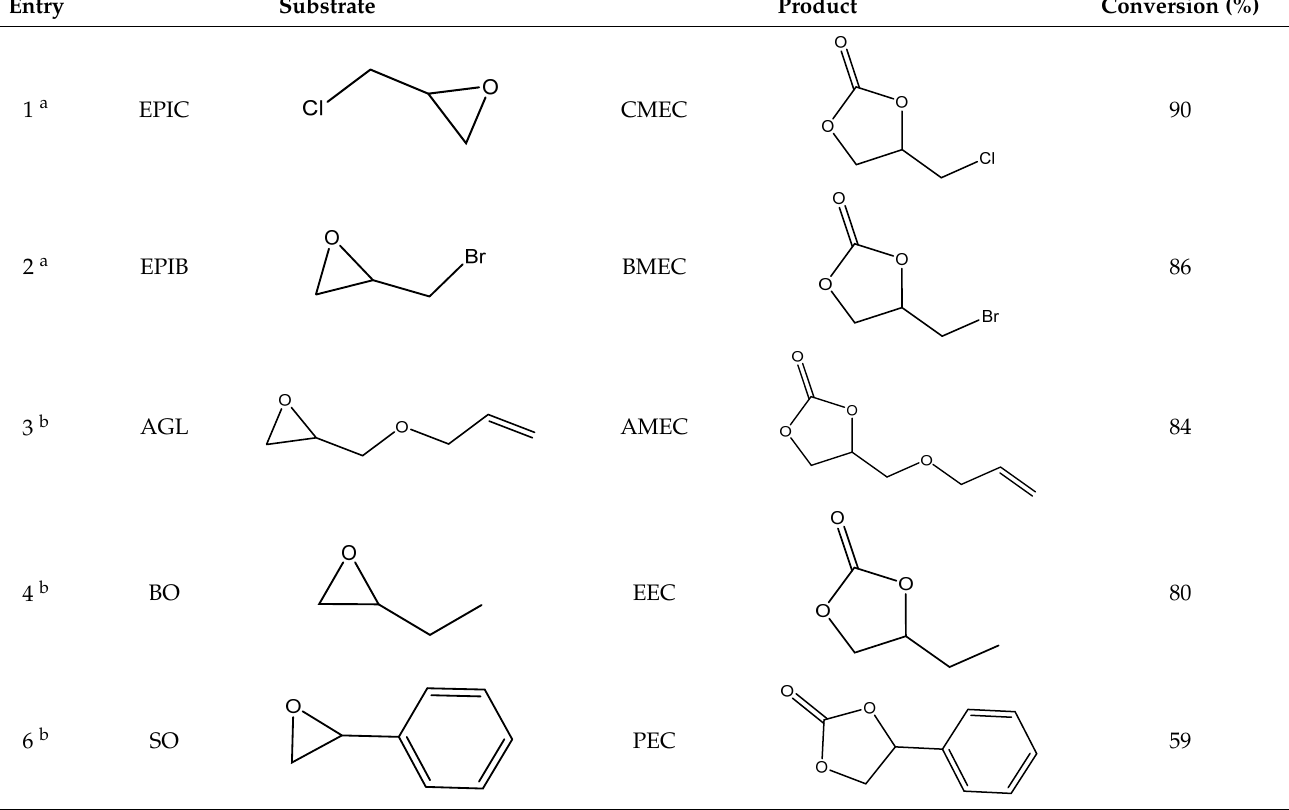
Table 15. Carbonation of different epoxides catalyzed by Bu 4 P.2-OPY at 0.1 MPa of CO 2 and at 30 ◦ C [69].